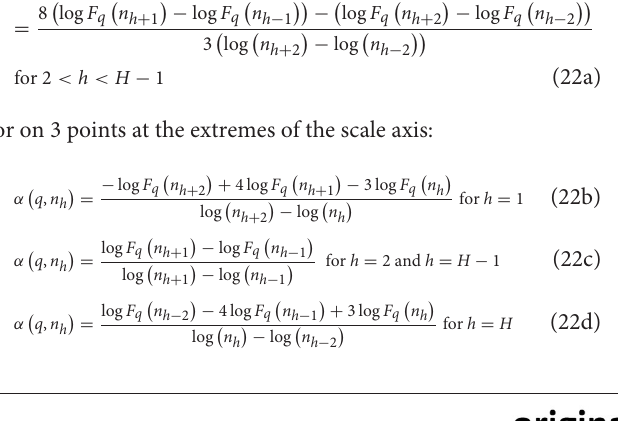
Frontiers in Physiology |